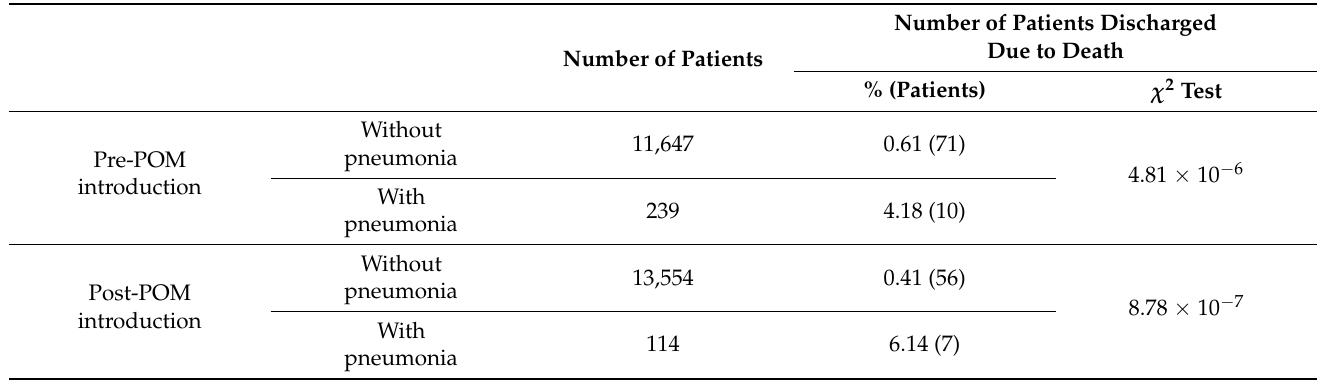
Table 4. Relationship between discharge due to death and the presence of postoperative pneumonia.